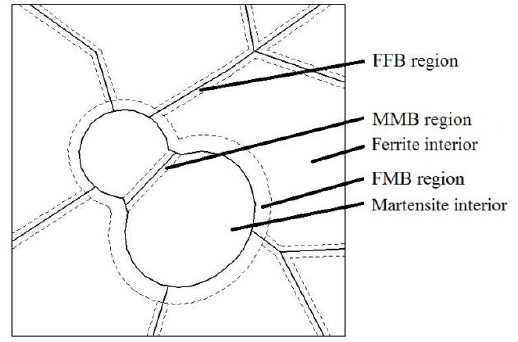
Figure 1. Schematic of the microstructure.